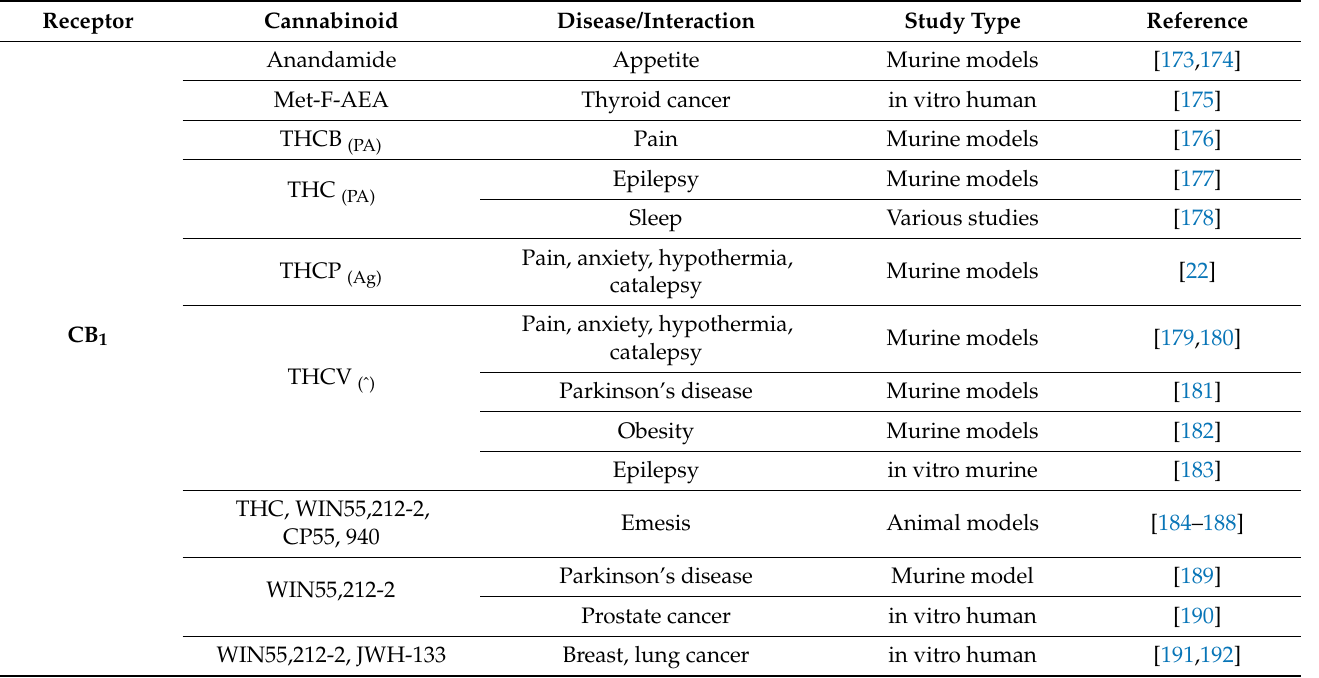
Table 1. Receptor modulation by cannabinoids and studies outlining their potential involvement in disease treatment. Receptor Cannabinoid Disease/Interaction Study